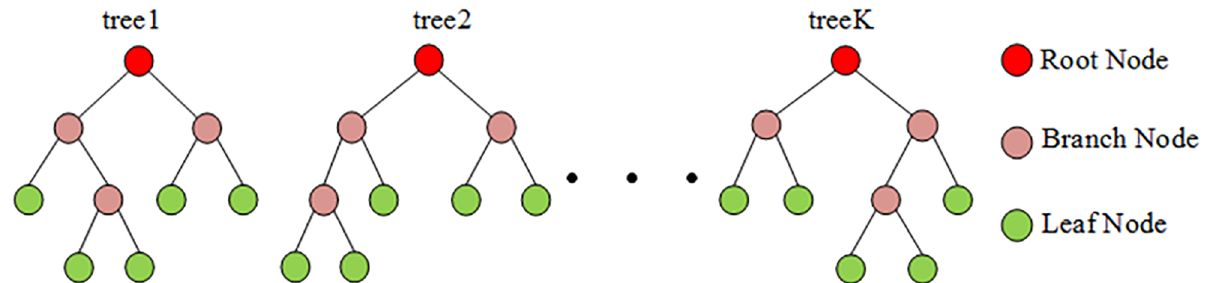
Fig 6. The structure of decision trees. Fig 6 shows K decisiontrees, which consist of the root node, branch node, and leaf node. The root node shows the starting point for the classification,which represents the most appropriate electricalsignal feature of the decisiontree. The branch nodesdivide the data into two clusters that have different rules. The leaf nodes obtain the electricaldata classification results.